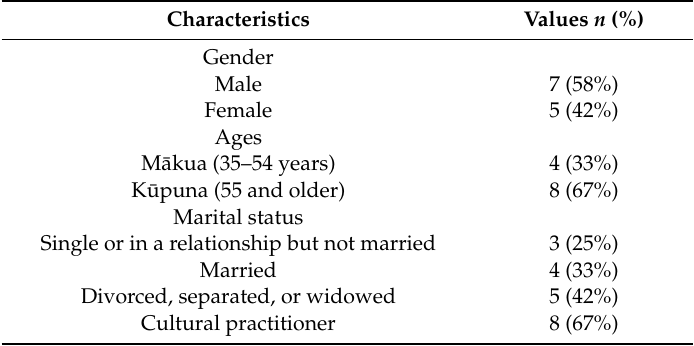
Table 1. Characteristics of key informant interview